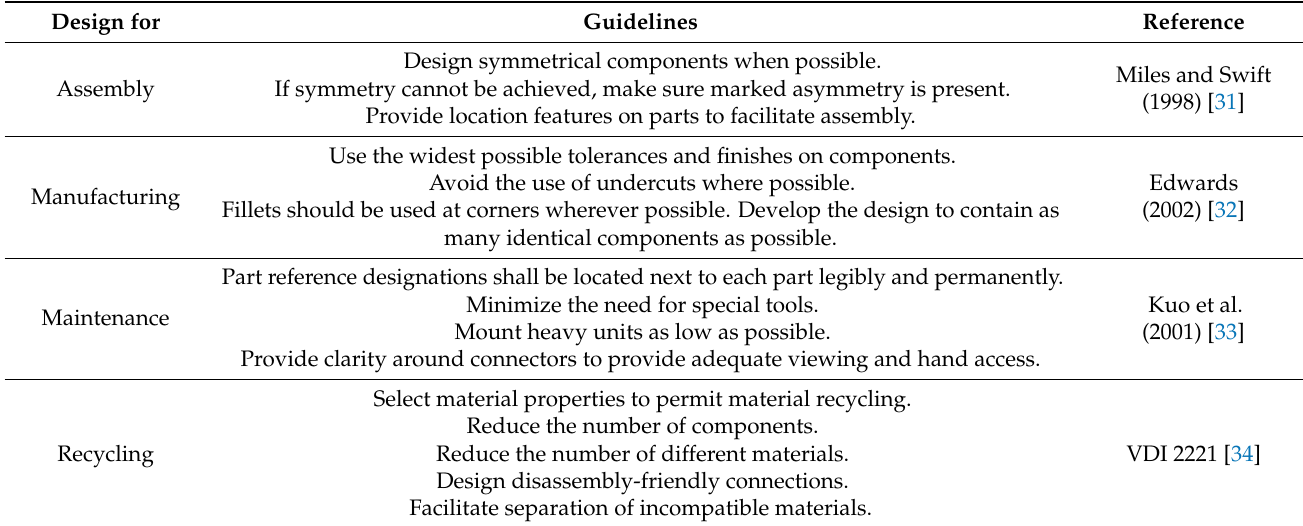
Table 1. Sample of some DfX